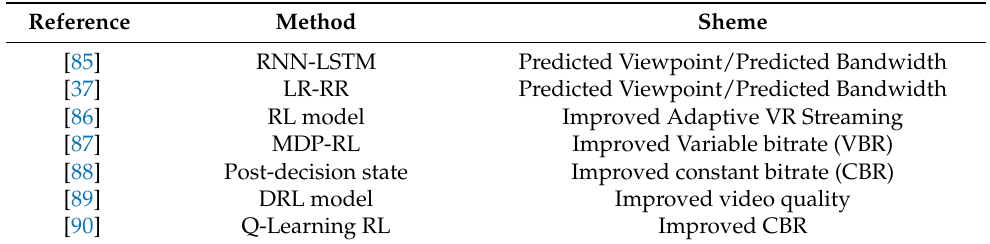
Table 1. Machine learning (ML)-based approaches to improve the quality of experience (QoE).